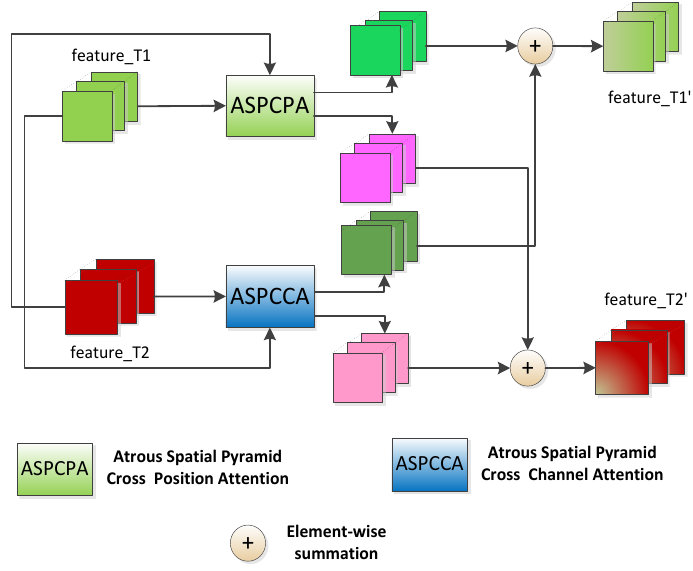
Figure 3. Structure of the atrous spatial pyramid cross-attention module.